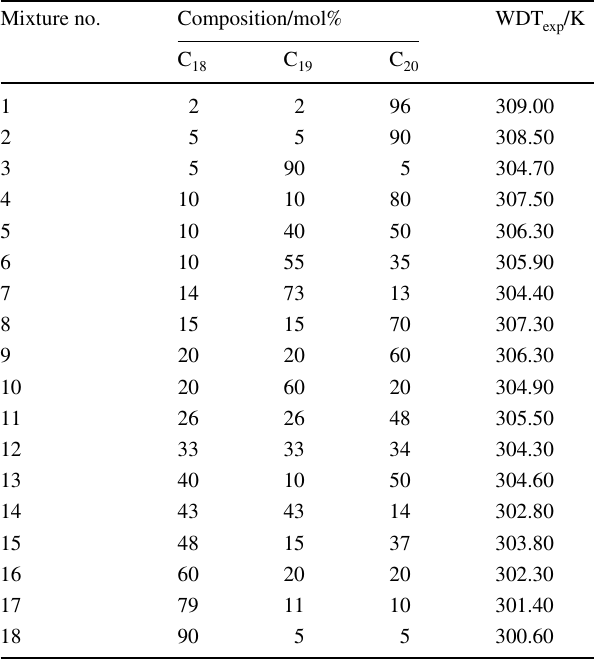
Table 5 Laboratory WDT/K values for system #3 (Metivaud et al. 1999) Mixture no.